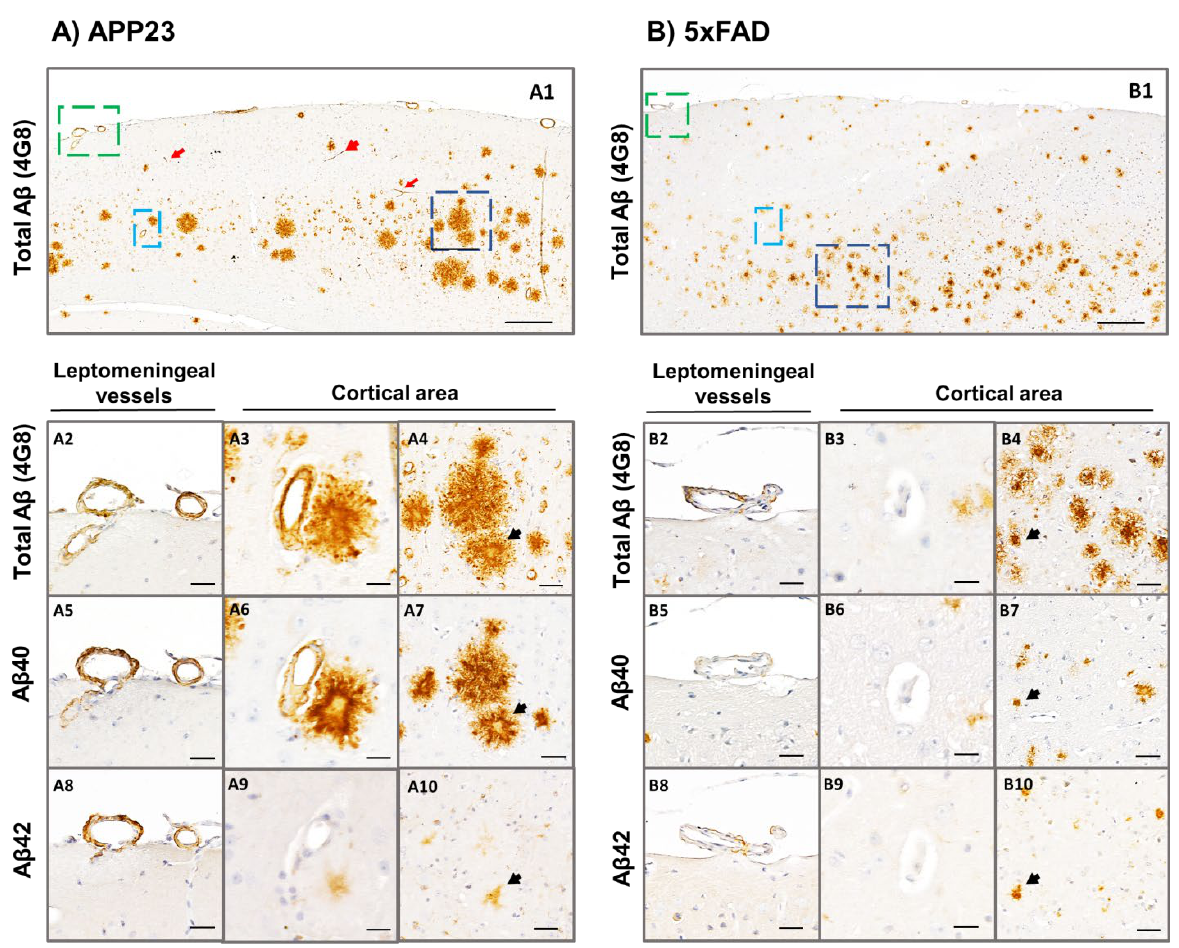
Figure 4. Specific A β 40 and A β 42 immunodetection in the parenchyma and cerebral vasculature in APP23 and 5xFAD mice. Total A β (determined by anti-4G8), A β 40, and A β 42 immunodetection analyzed in brain sections of: ( A ) 16-month-old female APP23:and, ( B ) 5xFAD (mice. Zoom images from leptomeningeal vessels (green), cortical vessels (cyan), and amyloid plaques (dark blue) are shown in A2–A10 panels for the APP23 model and in B2-B10 panels for the 5xFAD model. A2–A4 and B2–B4 represent consecutive brain sections stained with anti-4G8 primary antibody; A5–A7 and B5–B7 represent consecutive brain sections stained with anti-A β 40 primary antibody; and A8–A10 and B8–B10 represent consecutive brain sections stained with anti-A β 42 primary antibody. Red arrows in A1 indicate amyloid-affected capillaries in APP23 brains. Black arrows in A4–A10 and B4–B10 indicate the same amyloid-plaques analyzed in consecutive sections using different primary antibodies. Scale bar in A1/B1 indicates 200 µ m and in A2–A10 and B2–B10 indicates 40 µm.